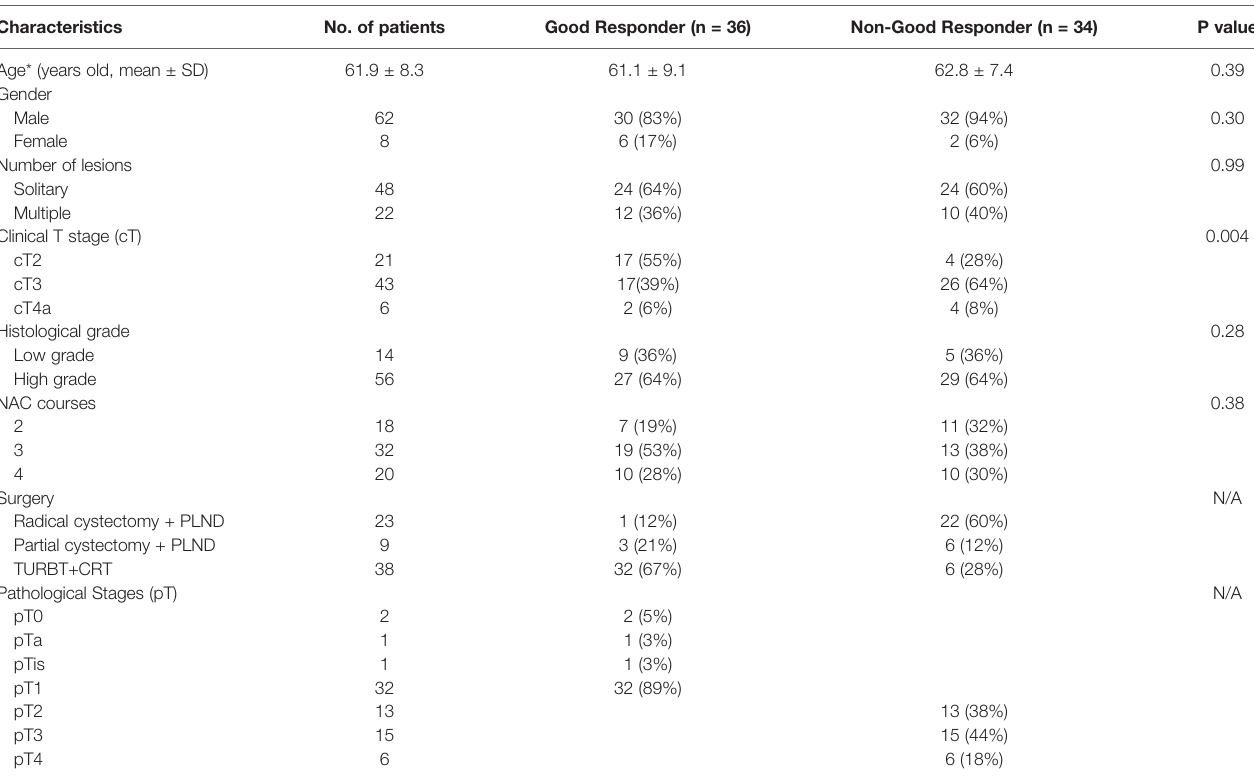
TABLE 2 | Characteristics of patients with